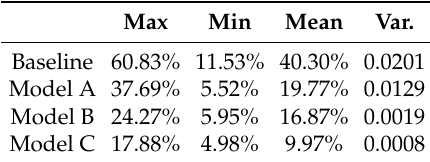
Figure 16. Trajectory relative error of Sequence 11. Table 8. Statistics of camera trajectory relative